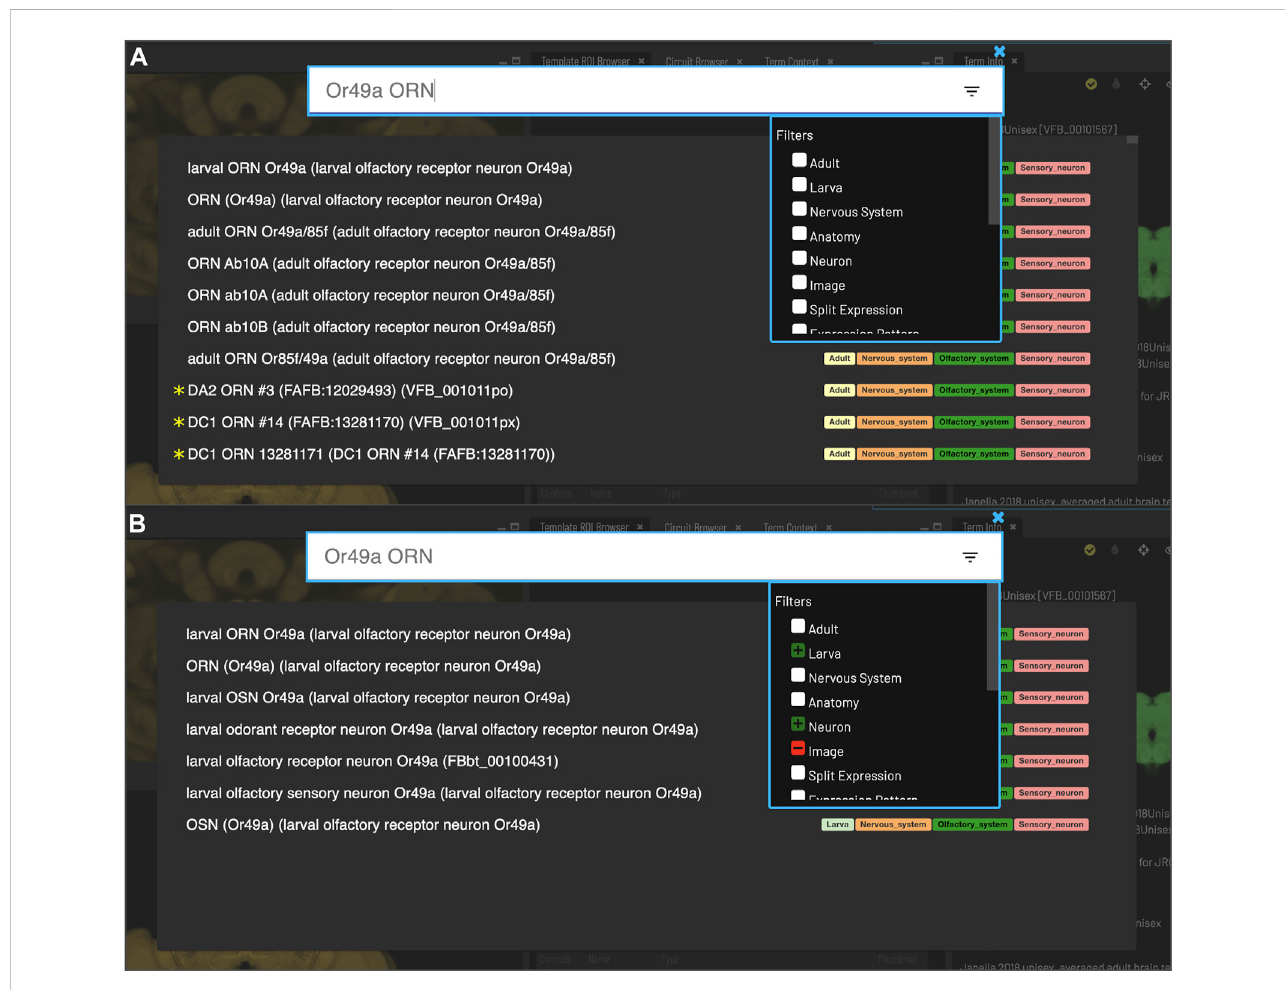
FIGURE 3 Search .Clicking themagnifyingglassinthetoprightofthepagewillopentheSearchtool.Searchingbasedonsynonymsissupportedandsemantictags on the right of each result provide extra information. Filters can be accessed by clicking on the lines on the right. (A) With no fi lters applied, results for “ Or49a ORN ” are a mixture of images (marked with *) and cell types from adult and larval stages. (B) To restrict results to larval neuron types, excluding images, fi lters can be applied to narrow down the results list, choosing a positive fi lter (green) for Larva and Neuron, and a negative fi lter (red) for